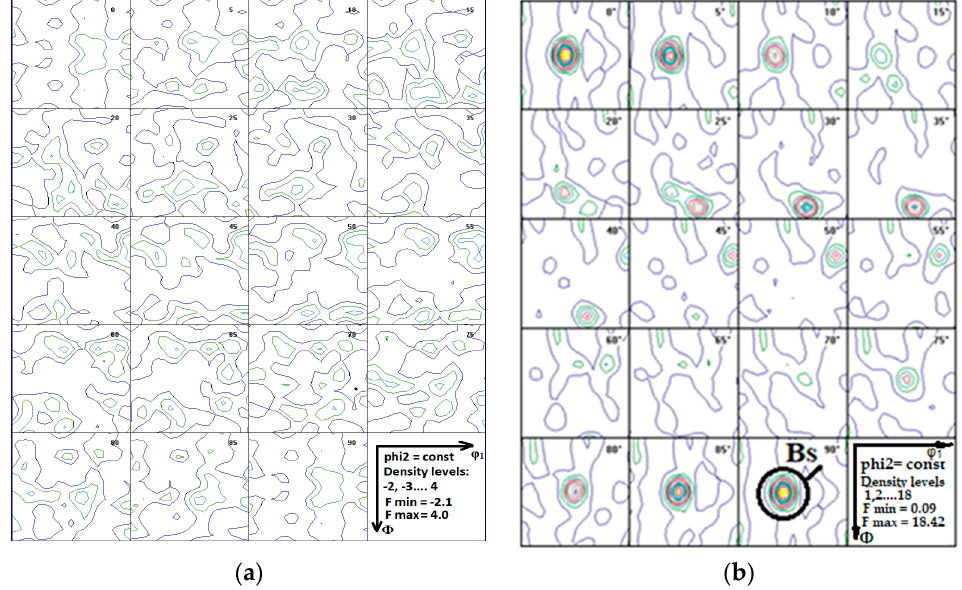
Figure 13. Texture composition for the AlMg 6 Mn 0.7 (1565ch) alloy: ( a ) cast state, ( b ) after the reversing stand.